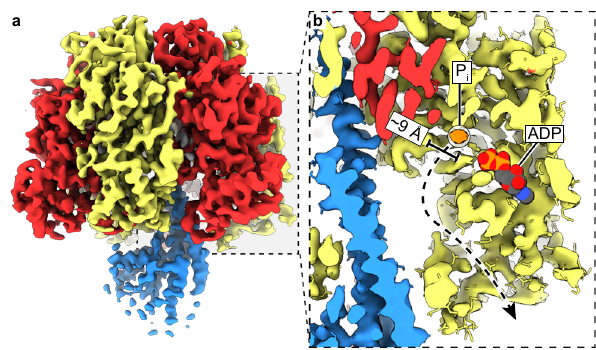
Fig. 5 The P i -bound dwell and alternative P i path. a Cryo-EM map of the P i -bound dwell. b Zoomed in section of the P i -bound dwell with the ADP molecule from the catalytic-dwell β site docked and shown as spheres 320 (cid:1) with CPK coloring. The alternative P i exit channel (black dashed arrow with a minimum diameter of 9 Å) could facilitate dissociation of the P i (corresponding map in orange and circled), while MgADP remains bound (also see Supplementary Fig.